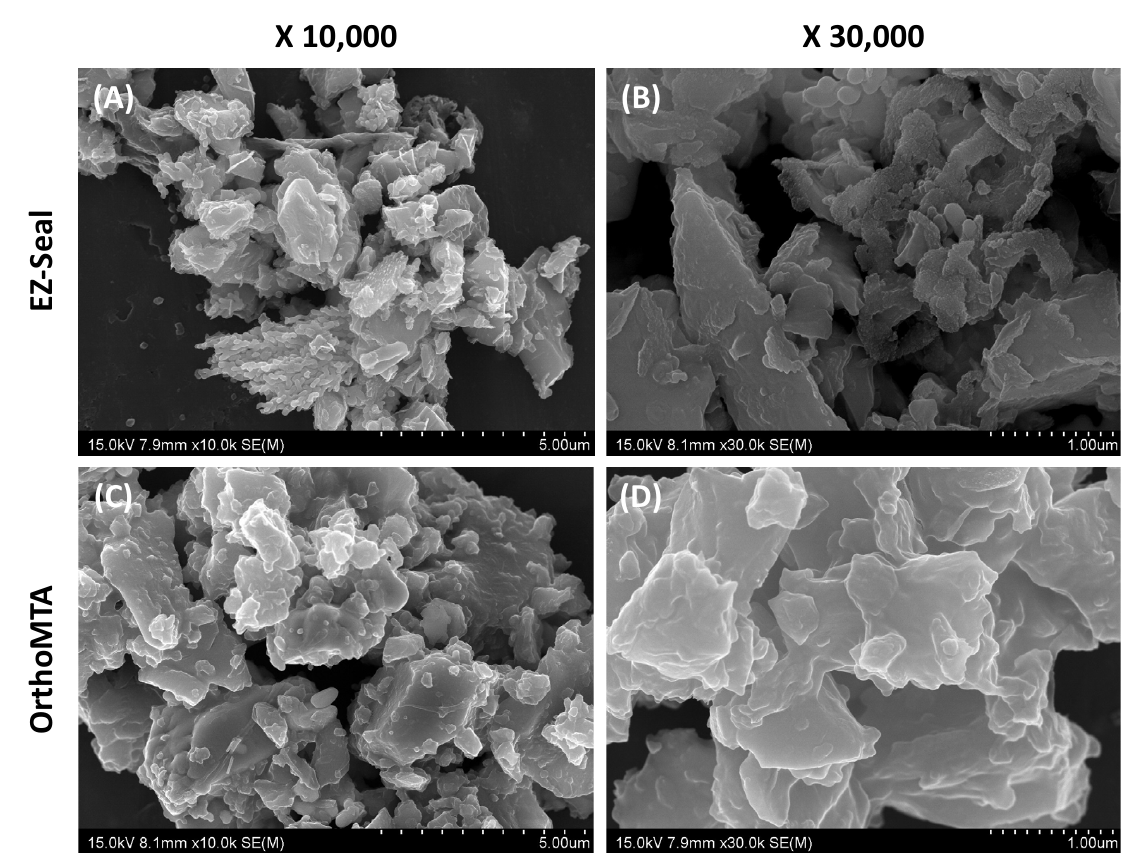
Figure 4. Scanning electronic microscopic (SEM) analysis of EZ-seal and OrthoMTA. EZ-Seal showed angular shapes and sharp points at low ( A ) and high ( B ) magnification. OrthoMTA showed homogeneous and circular at low ( C ) and high ( D ) magnification.